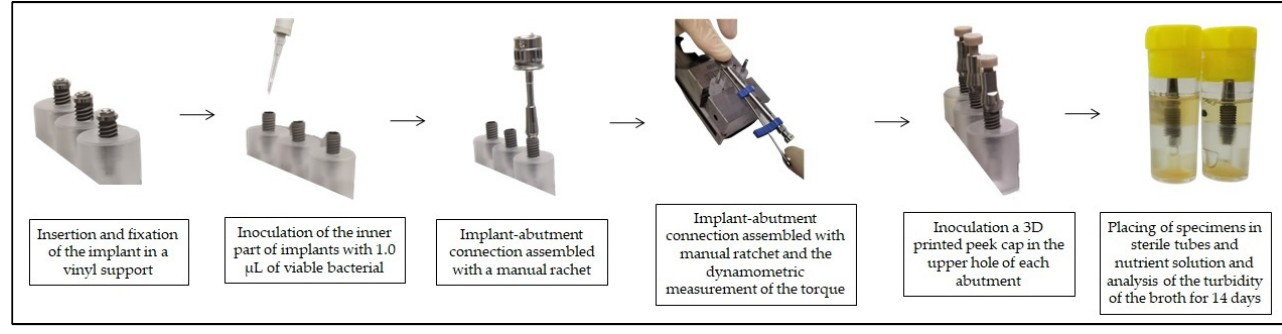
Figure 1. Study diagram.